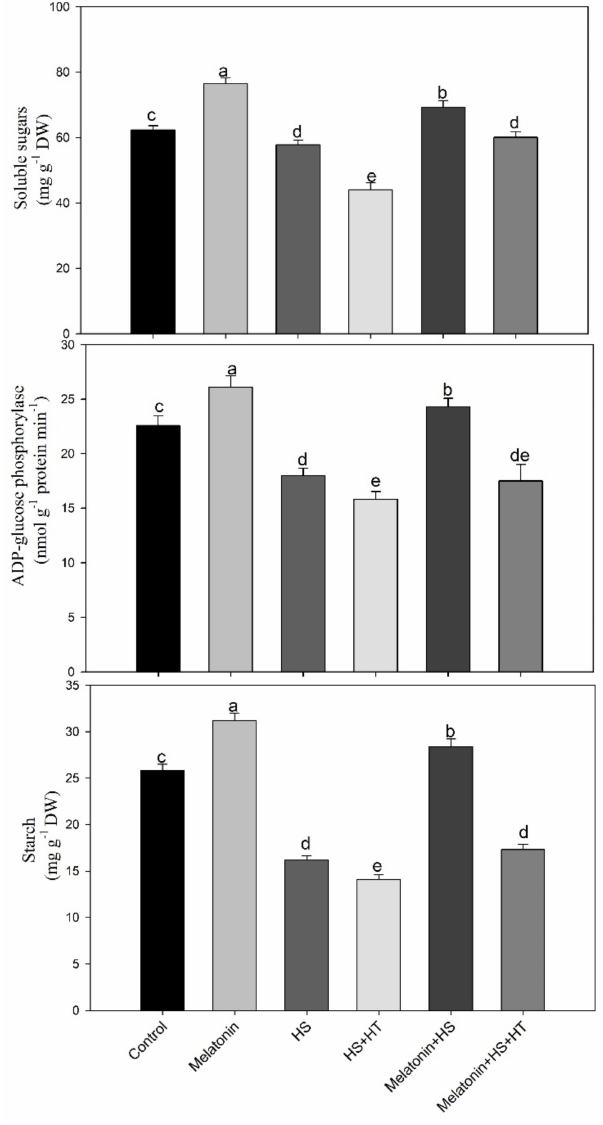
Figure 8. Total soluble sugars, activity of ADP-Glucose phosphorylase and starch content in wheat ( Triticum aestivum L. var. WH 542) leaves at 30 days after sowing (DAS). Plants were treated with melatonin (100 µ M) and/or hypotaurine (HT, 100 µ M) in the presence of (40 ◦ C) or absence (25 ◦ C) of heat stress. Data are presented as means ± SE ( n = 4). Data followed by the same letter are not significantly different by LSD test at p < 0.05. HS, heat stress; HT;